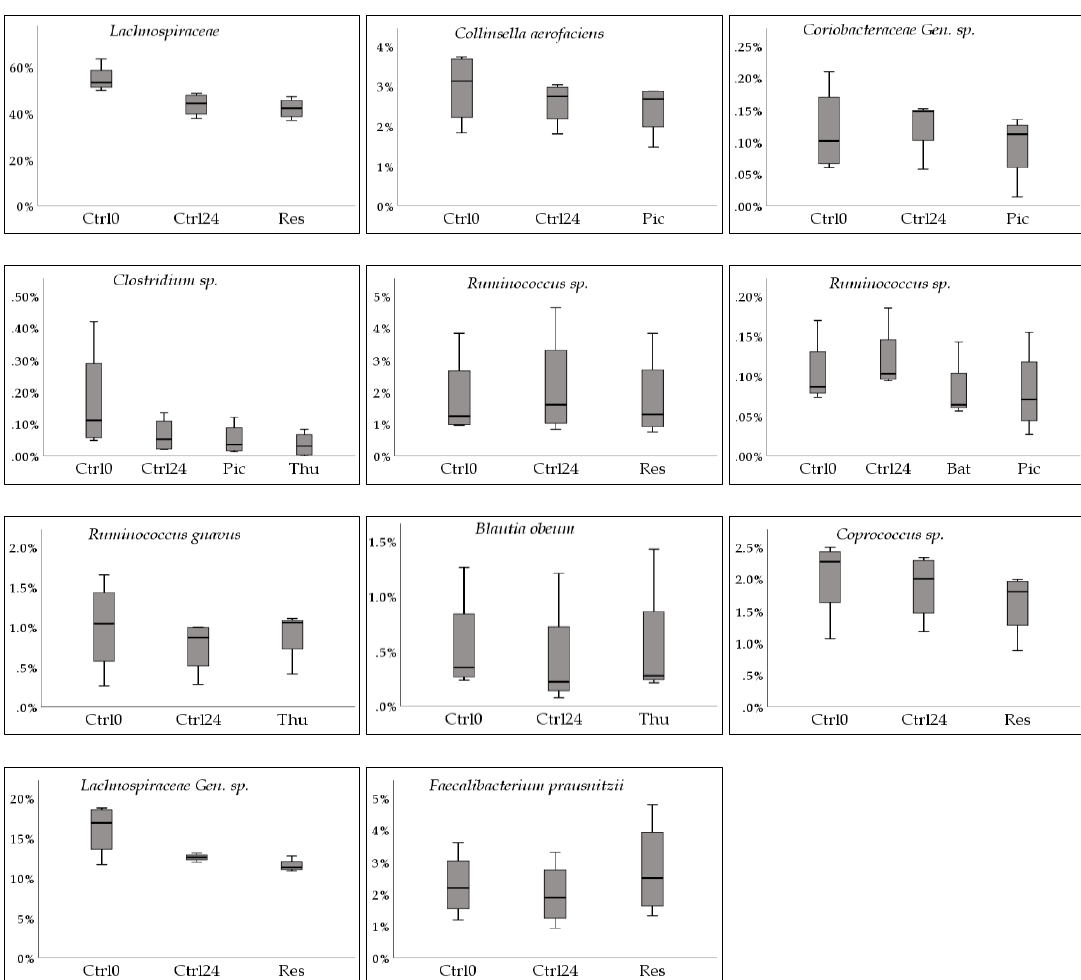
Figure 4. Box plots corresponding to the identified species and stilbenoids in Table A2. The y-axis displays relative abundance (%). The x-axis shows Ctrl0, control at 0 h; Ctrl24, control at 24 h; as well as the stilbenoid(s) corresponding to the observation (Bat, batatasin III; Oxy, oxyresveratrol; Pic, piceatannol; Pino, pinostilbene; Res, trans-resveratrol; Thu, thunalbene (all stilbenoids at 24 h). Gen. = unnamed genus, sp. = unnamed species.